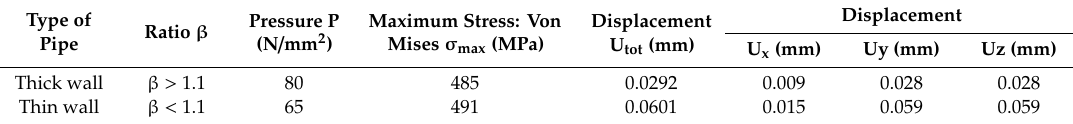
Table 4. The results of finite element analysis (FEA) simulation.